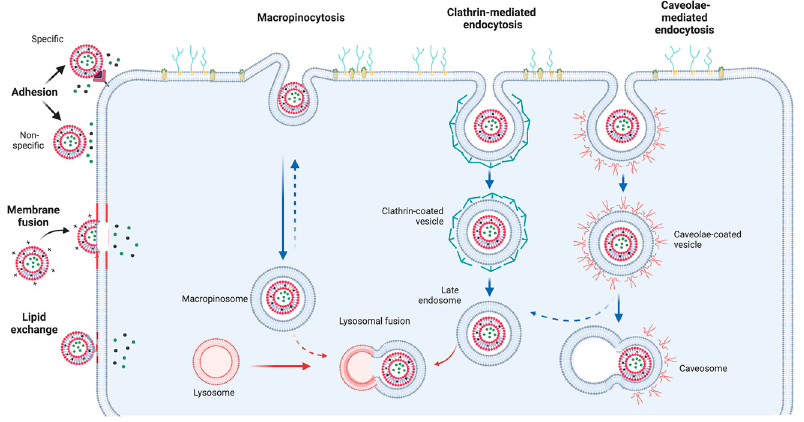
Figure 5. Liposome internalization and delivery mechanisms. The figure was created with BioRender accessed on 1 December 2022.